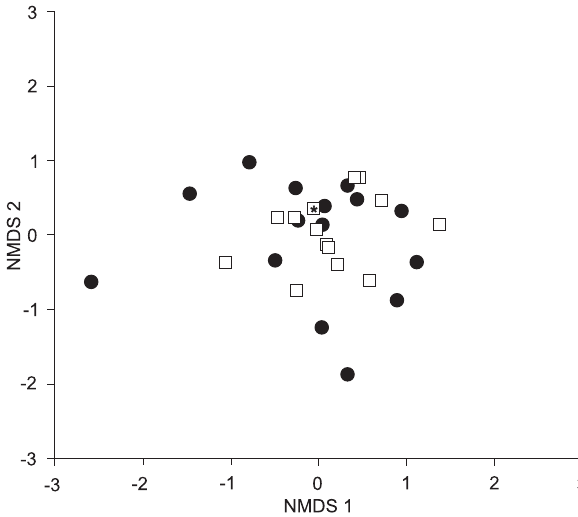
Figure 1. Multidimensional scaling analyses of the diet overlap in individuals of Anomaloglossus stepheni (black dots) and Leptodactylus andreae (white squares) living in the leaf-litter of Central Amazon. * Two individuals of L. andreae the same point. Stress configuration =